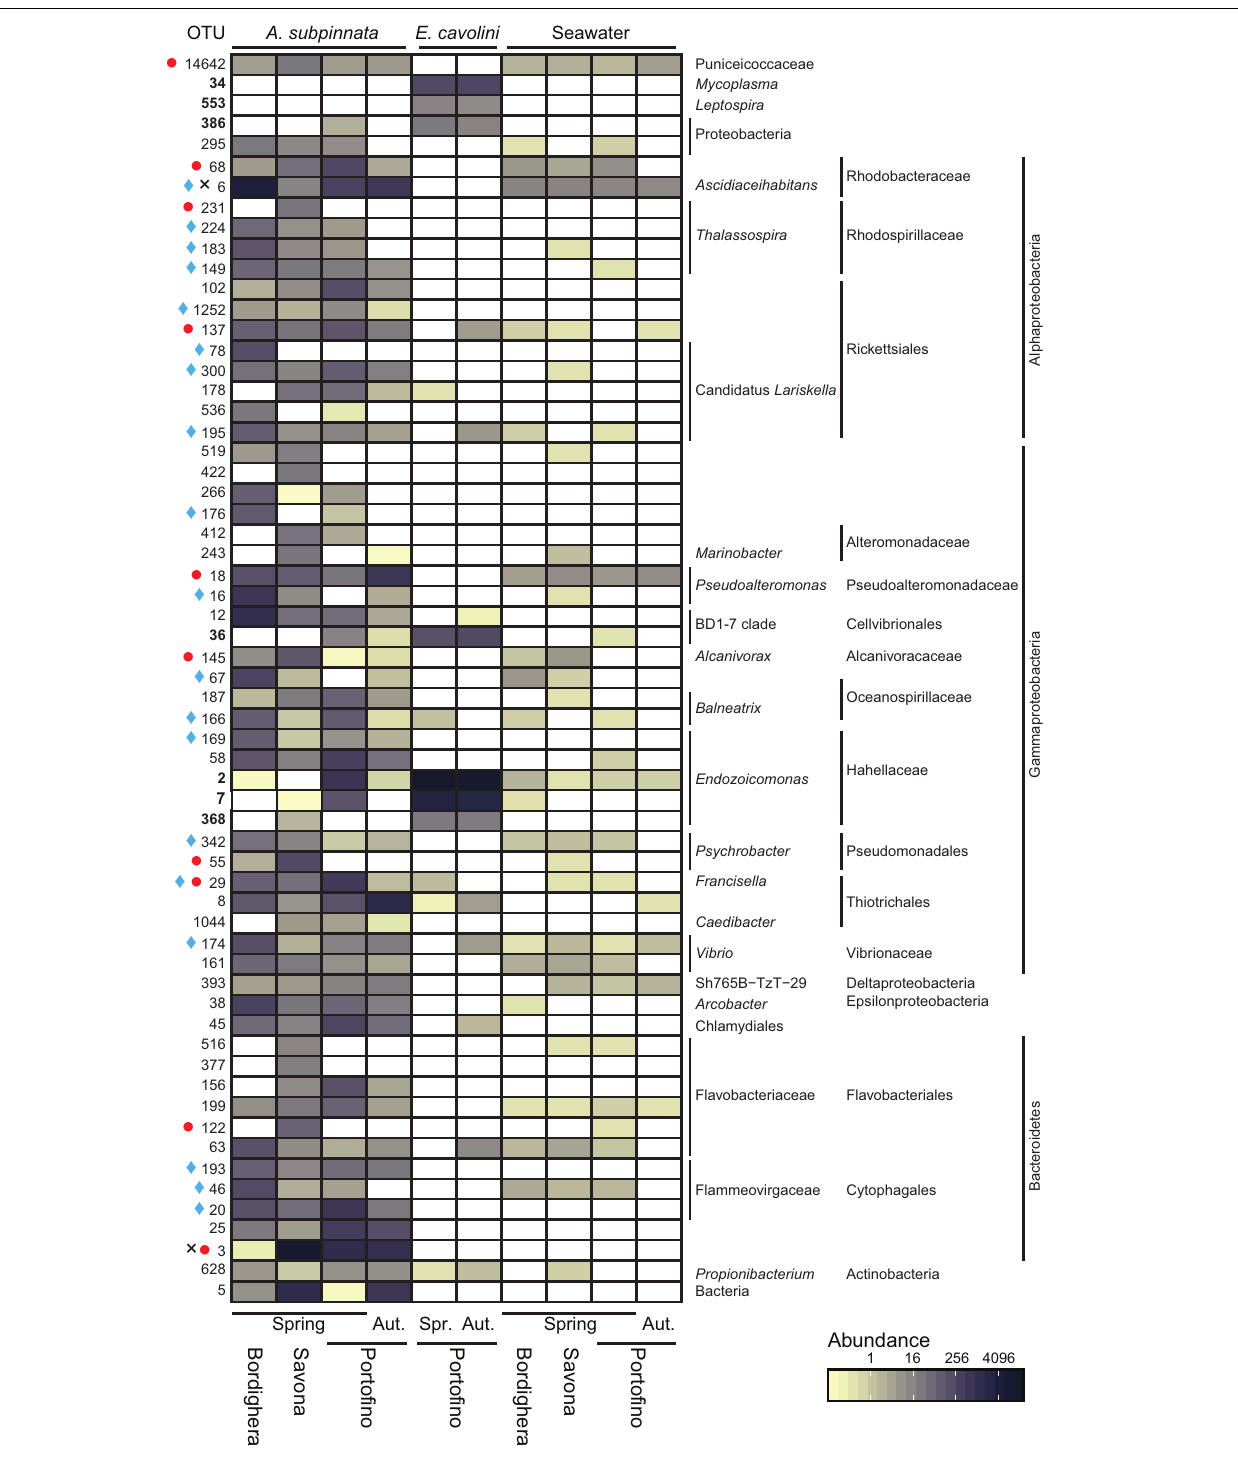
Frontiers in Microbiology |